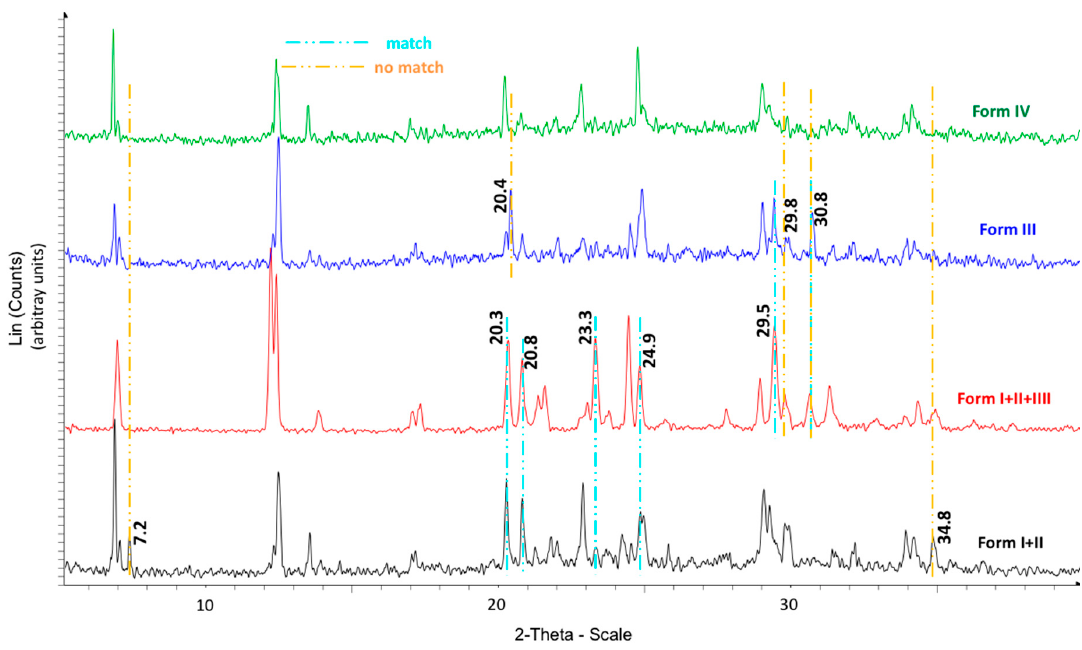
Figure 4 . X-ray diffractograms of the forms of VA6E obtained after successive cycles of melting–recrystallization.